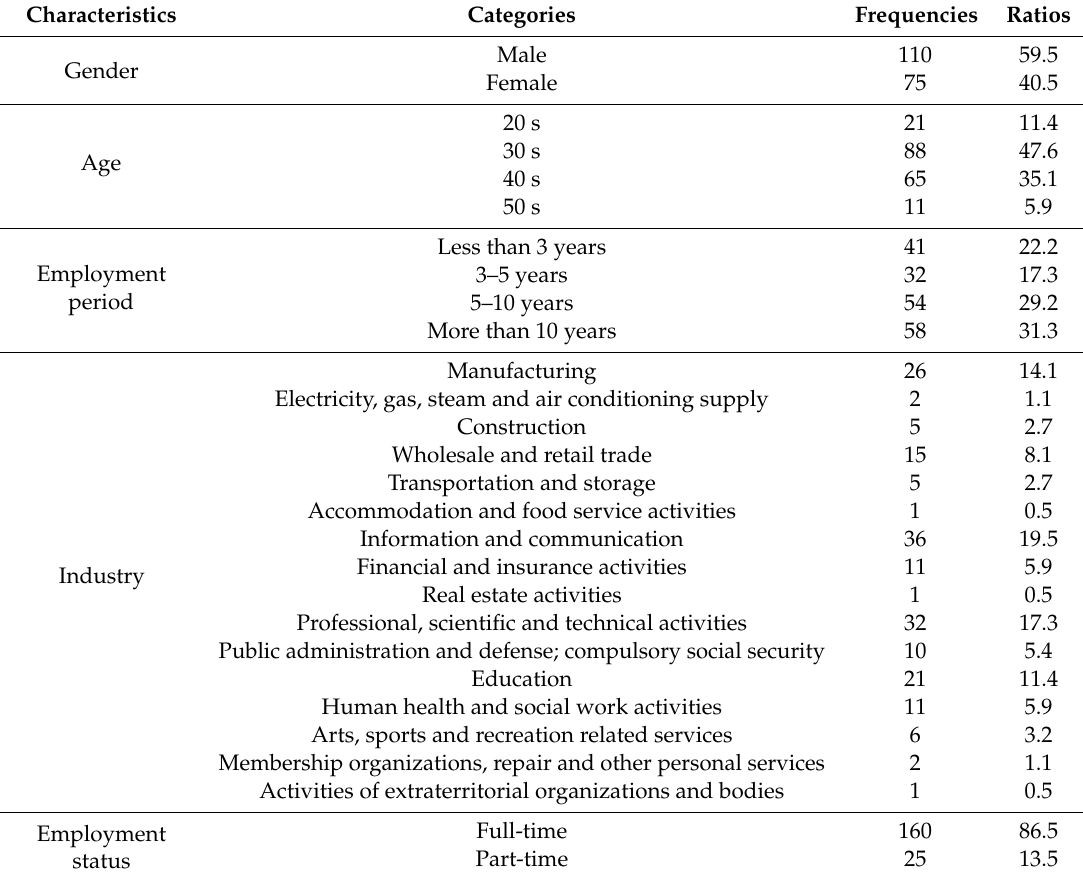
Table 1. Demographic characteristics of